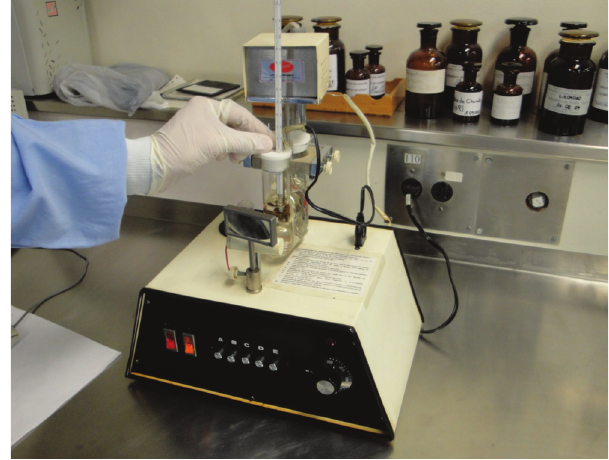
Figure 1 - Fusion point tests of Oseltamivir